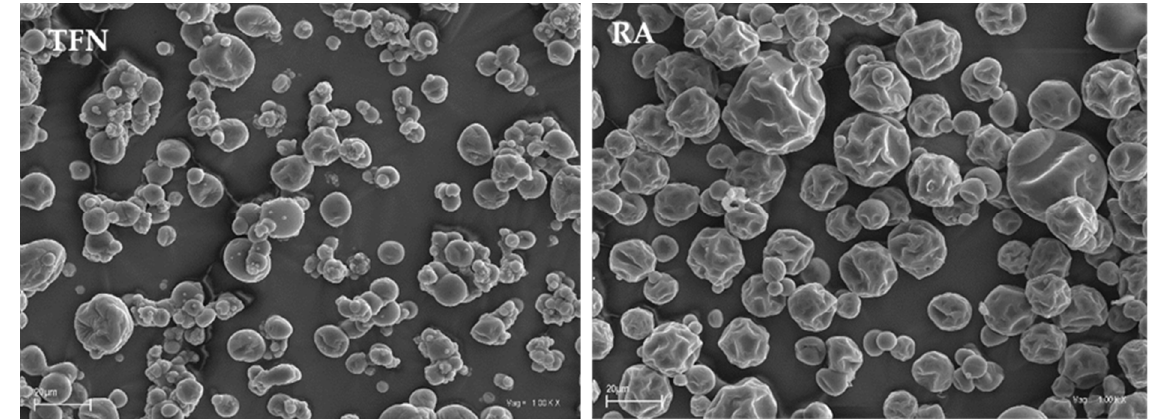
Figure 3. A comparison of particle morphology of two different liquid spray systems (magnification 1000 × ): two-fluid nozzle (TFN) and rotary atomizer